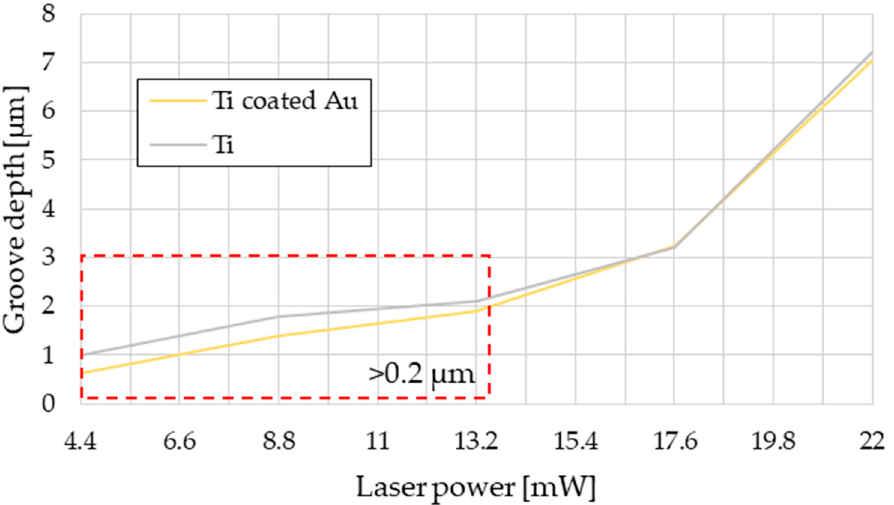
Figure 6. Laser power to groove depth diagram based on confocal results, with the region excluded from statistical investigation (red frame) .